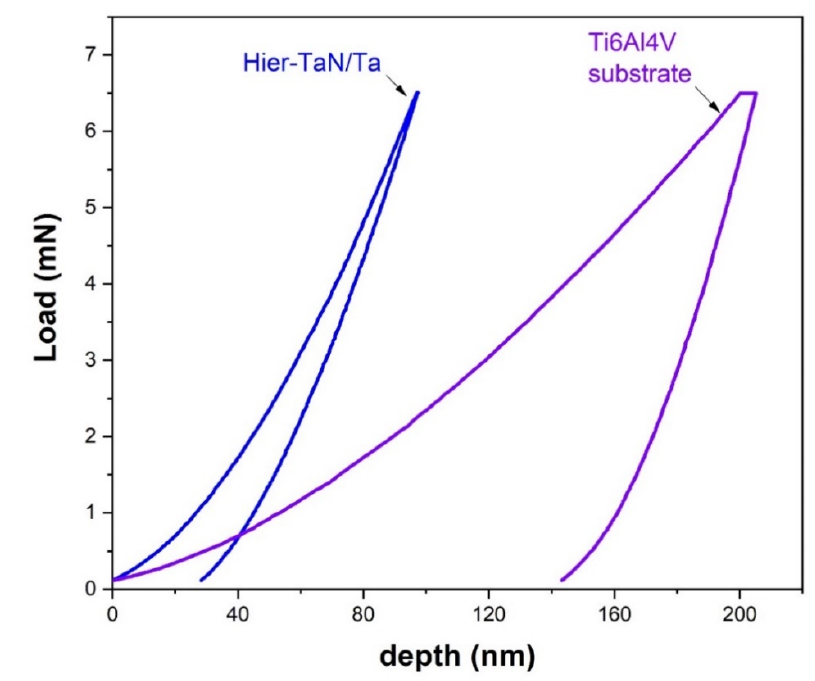
Figure 4. Load–displacement curves for the Hier-TaN/Ta coating and Ti6Al4V substrate. Table 1. Mechanical properties obtained from the nanoindentation